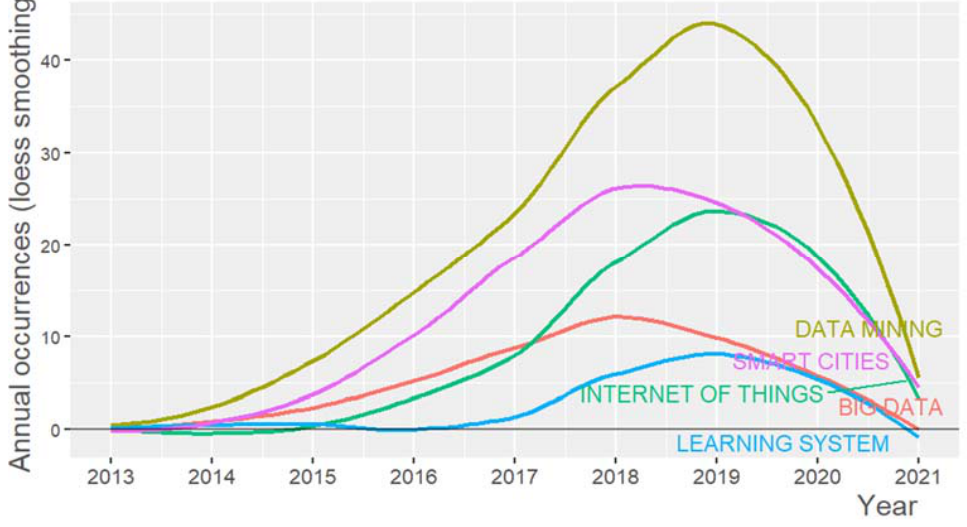
Figure 11. Word dynamic graph.